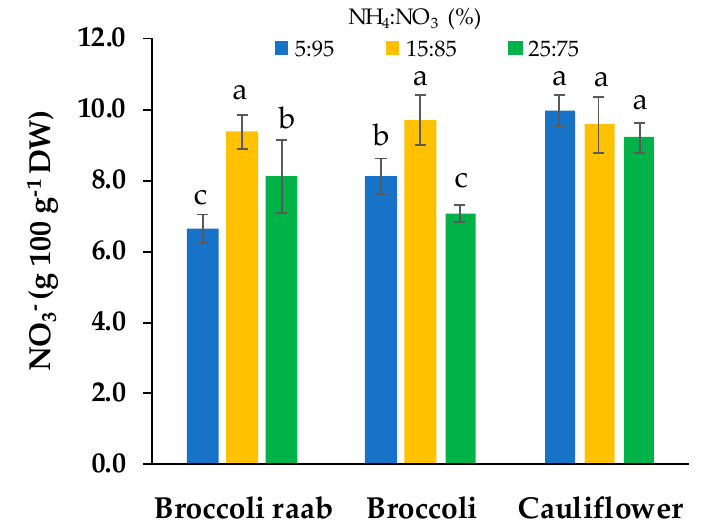
Figure 3. Nitrates (NO 3 − ) content of three genotypes of microgreens grown by using a NS with three di ff erent NH 4 + :NO 3 − (%) molar ratios: 5:95, 15:85 and 25:75. Di ff erent letters indicate that mean values are significantly di ff erent, according to the SNK test ( p = 0.05). Vertical bars represent ± standard deviation of mean values.